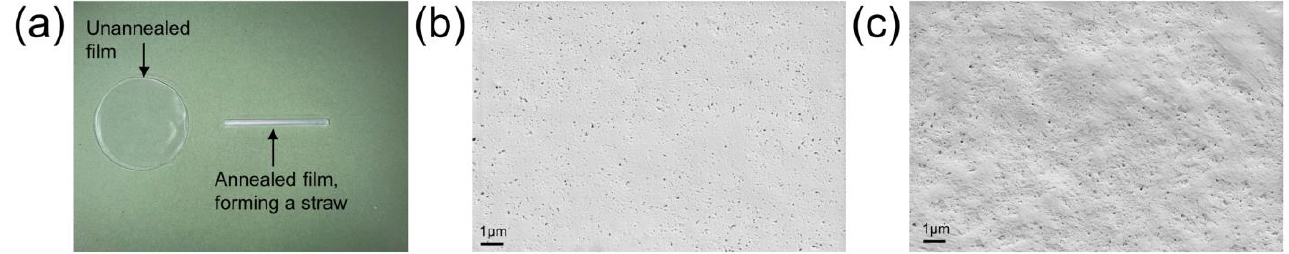
Figure 1. ( a ) Photo of SC-PLA film and straw. ( b ) SEM image of unannealed SC-PLA film and ( c ) SEM image of annealed SC-PLA straw.